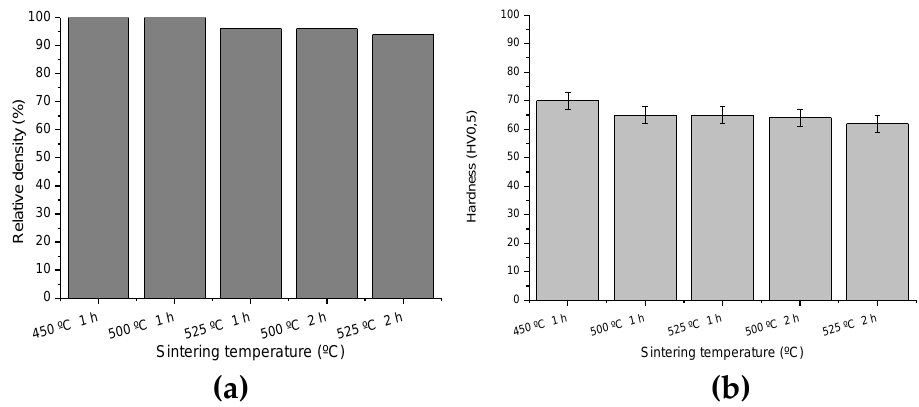
Figure 14. ( a ) Relative density (%) of HT compacts. ( b ) Hardness as a function of the temperature for Al–Cu–Li alloy.